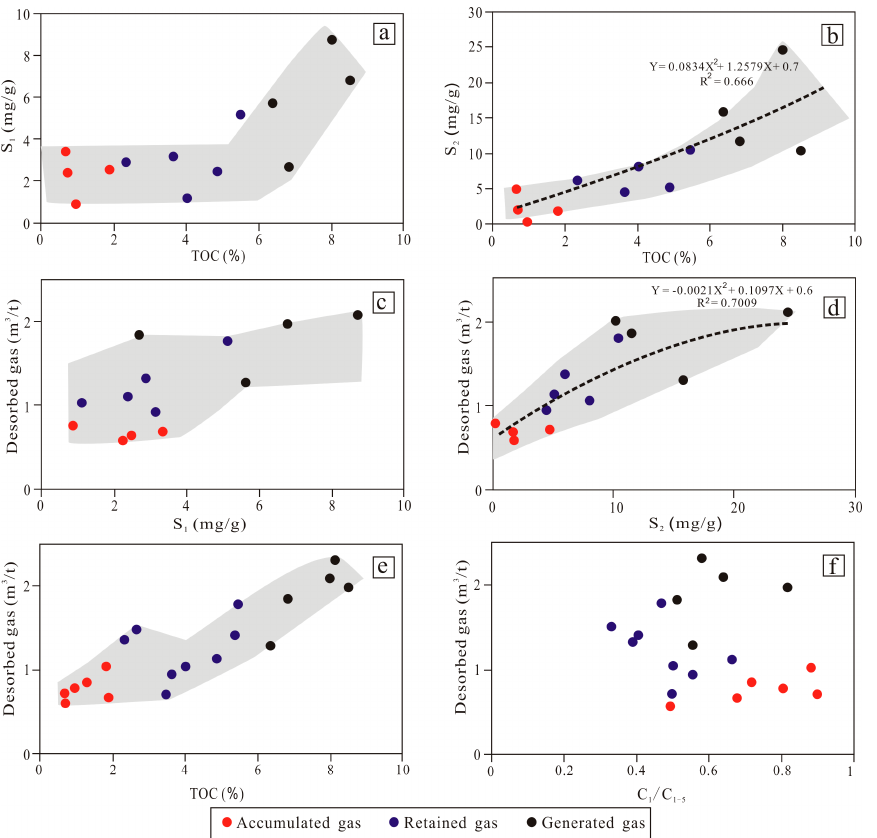
Figure 9. Parameter characteristics for classifying shale gas. ( a ) Relationship between TOC and S 1 ; ( b ) Relationship between TOC and S 2 ; ( c ) Relationship between desorbed gas and S 1 ; ( d ) Relationship between desorbed gas and S 2 ; ( e ) Relationship between desorbed gas and TOC; ( f ) Relationship between desorbed gas and C 1 /C 1–5 .